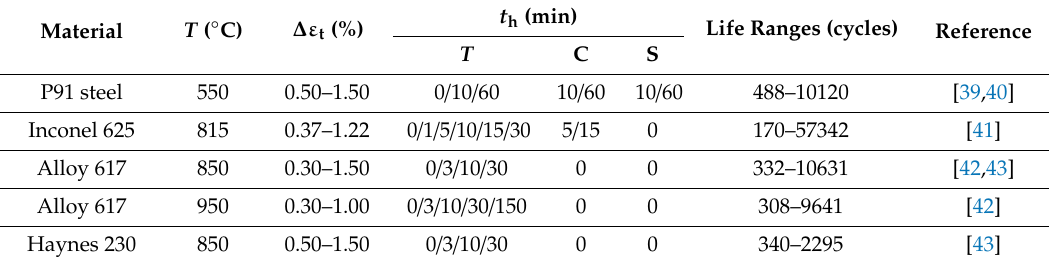
Table 1. Collected high-temperature fatigue and creep-fatigue test data.